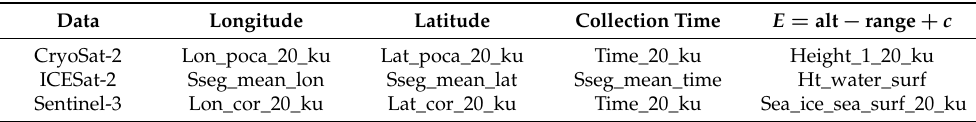
Table 2. Fields of satellite altimetry data used in this study.